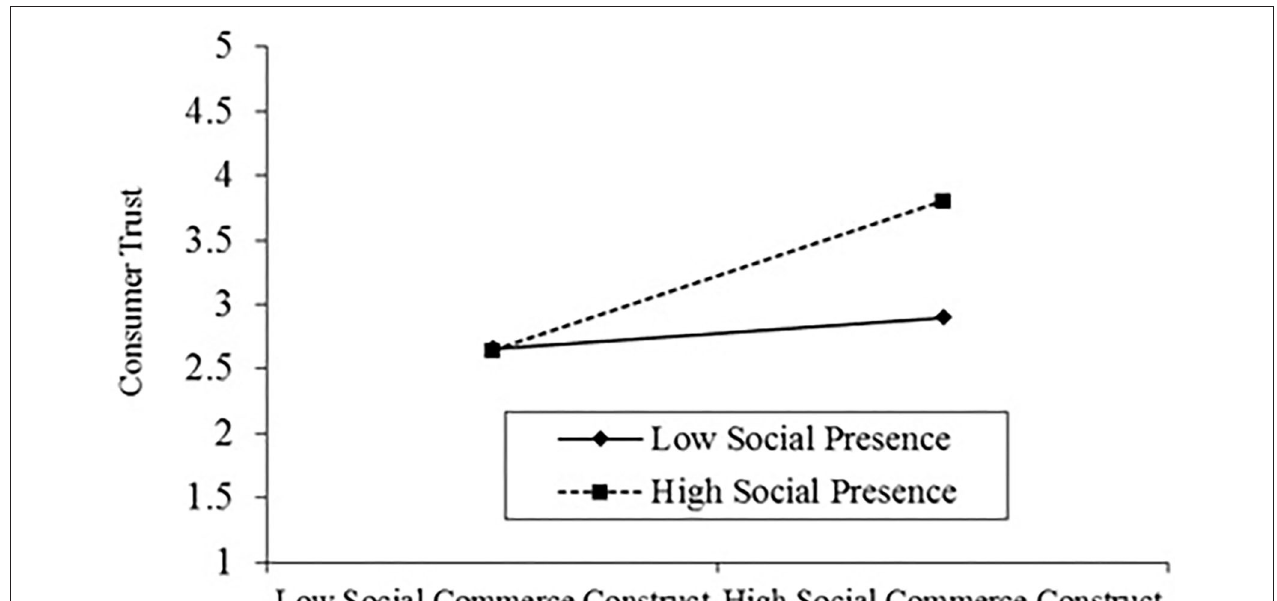
FIGURE 2 | Showing